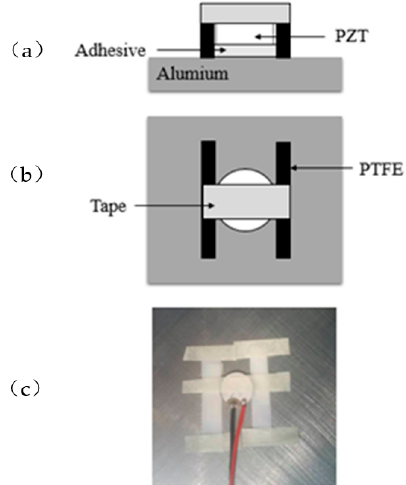
Figure 9. Control method of adhesive thickness without debonding: ( a ) positive view image; ( b ) top view image; ( c ) actual diagram.